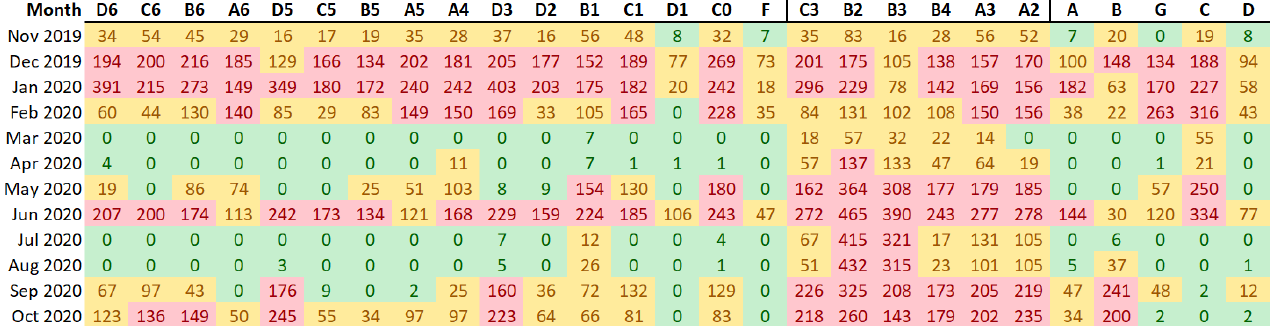
Figure 11. Number of out-of-band observations for each month (in row) and each data-logger (in column) by considering a common band width. Such band was computed as the median of the band resulting from applying the standard EN 15757:2010 individually to each data-logger. The lowest tercile (i.e., percentile 33) of values are highlighted in green, the highest tercile in red, and the rest in light orange.